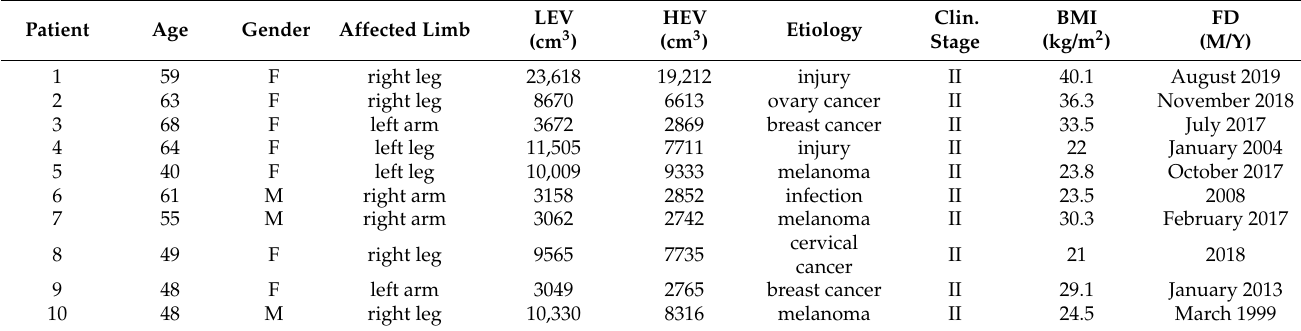
Table 2. Study population. Abbreviation: (LEV) lymphedema extremity volume in cm 3 , (HEV) healthy extremity volume in cm 3 , (BMI) body mass index, (FD) First